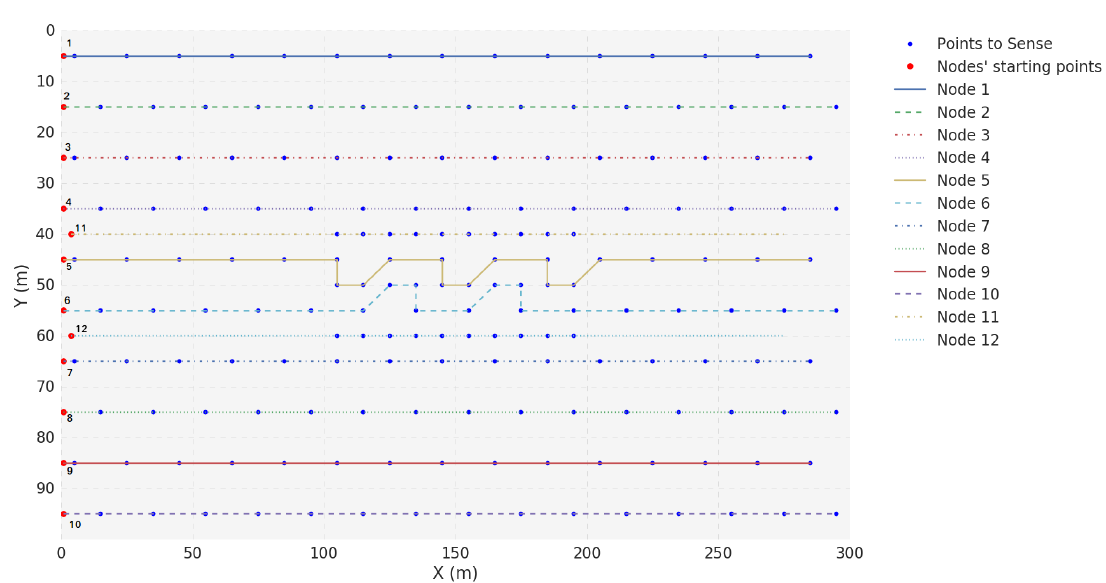
Figure 16. Position progress of each USV in Scenario